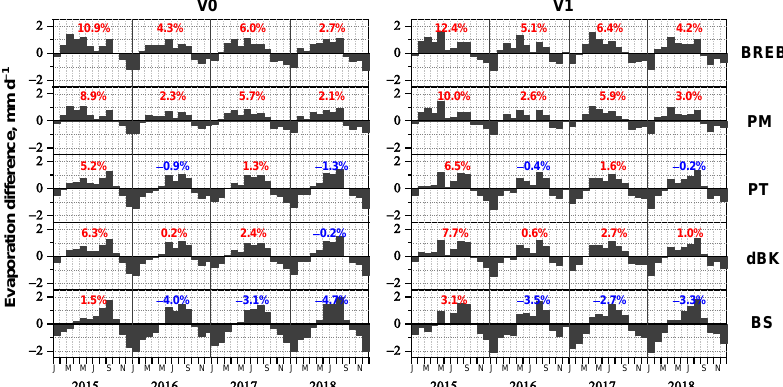
Figure 4. Difference in monthly evaporation (mm d −1 ) between five combination methods (BREB, PM, PT, dBK, and BS) and EC observations under default condition V0 and calibrated condition V1. The percentage represents the difference in annual total evaporation loss.